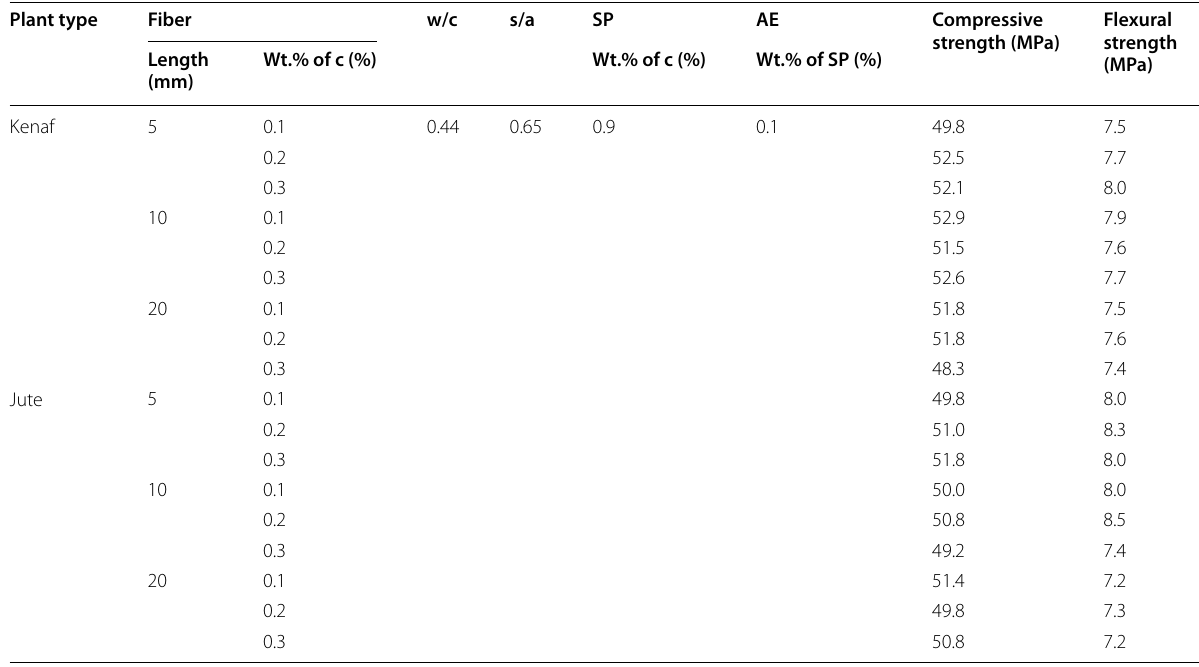
AE air-entraining agent